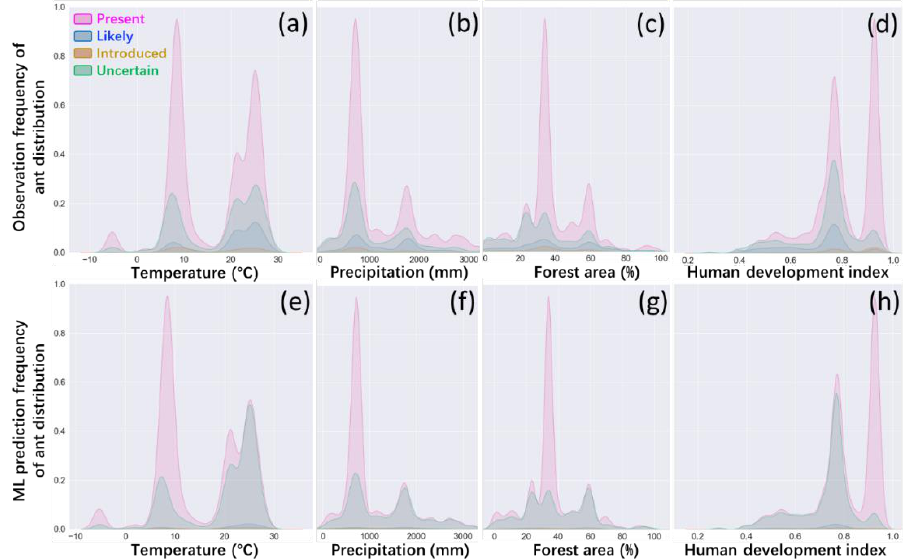
Figure 3. Observation frequency ( a – d ) versus prediction frequency ( e – h ) of ant distribution. The Y -axis shows the frequency from 0 (the amount of data equal to 0) to 1 (the highest possible amount of data). Coloured areas indicate that the observation frequency (upper Y -axis) and ML prediction frequency (lower Y -axis) of ant distribution are currently present (pink) or likely (blue) or introduced (yellow) or unknown (green) under certain conditions of temperature, precipitation, forest area, and human development index ( X -axis).